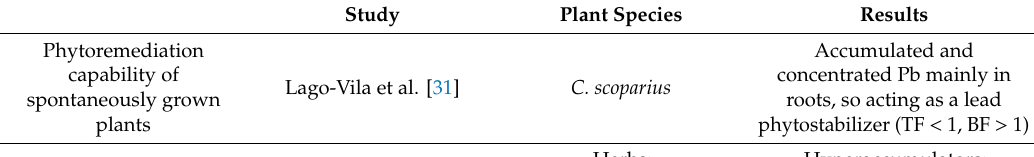
Table 2. Summary table of phytoremediation studies carried out in Pb-contaminated